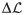
CANN model for interplay between path integrator, external stimuli, and memory.A. Phenomenology of the CANN model. The model is composed of a recurrent hippocampal network that has memorized two cognitive maps (place fields dispositions) denominated A and B, a path integrator input (PI), and a visual input (V). In the left panel both PI and V are activating place cells whose place-field centers (shown by blue dots) correspond to the position of the rodent (red cross X) in the cognitive map A. The activity is said to be localized in a bump around X in t map A, while it appears as sparse and uninformative if interpreted with respect to the place-field locations in map B. A feedback projection (blue arrows) from the hippocampal state (bump) to the path-integrator state (purple) maintains the stability of the system by enforcing that the retrieved hippocampal map and the PI state agree. After the light conditions have been switched (teleportation, red line), V projects on place cells encoding position X in map B. The two hippocampal cognitive maps are therefore in conflict, and the bump of activity is alternatively localized in A (center-top) or in B (center- bottom). When the hippocampal activity is localized in the cognitive map B, the feedback projection tries to realign the internal state of PI along the corresponding map. Once the realignment has succeeded (green line), both inputs are back to a coherent state, and stability is reached in the cognitive map relative to the post-teleportation external light conditions. B. Representation of the effective model for the activity bump and effects of parameters. The input strengths, γPI and γV, contribute to push the hippocampal activity towards the corresponding cognitive states. Increasing the strength of recurrent connections, γJ, results in an effective barrier separating the two collective hippocampal states, giving rise to well formed bumps in either map A (left) or in map B (right). Due to this effective trap the bump state remains localized in either map for more than a single theta bin. C. Temporal correlation of flickering events (theta bins with cognitive state opposite to external light conditions) decay over c.a. 7 theta bins in simulated data. Same model parameters as in Fig 3. D. Time trace of the log-likelihood difference ΔL (Eq (13) in Methods) in a simulated teleportation session; flickers can be observed during the conflicting phase following teleportation (shaded region). Prior to teleportation, and after the PI is realigned, inputs are coherent, and the system is stable: the sign of ΔL is constant, mirroring the localization of the bump in one map. Screenshots of the activity projected on the two cognitive maps are shown for five different times. From left to right: bump localized in map A, bump localized in map A during the conflicting phase, mixed state during the conflicting phase, bump localized in map B during the conflicting phase, bump localized in map B. The video of the simulation can be found in SI.